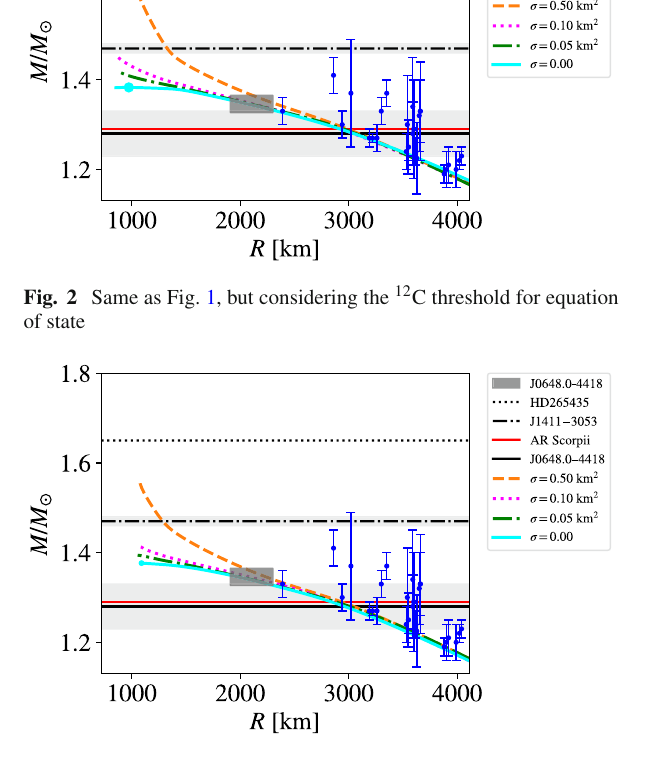
Fig. 3 Same as Fig. 1, but considering the 16 O threshold for equation of state